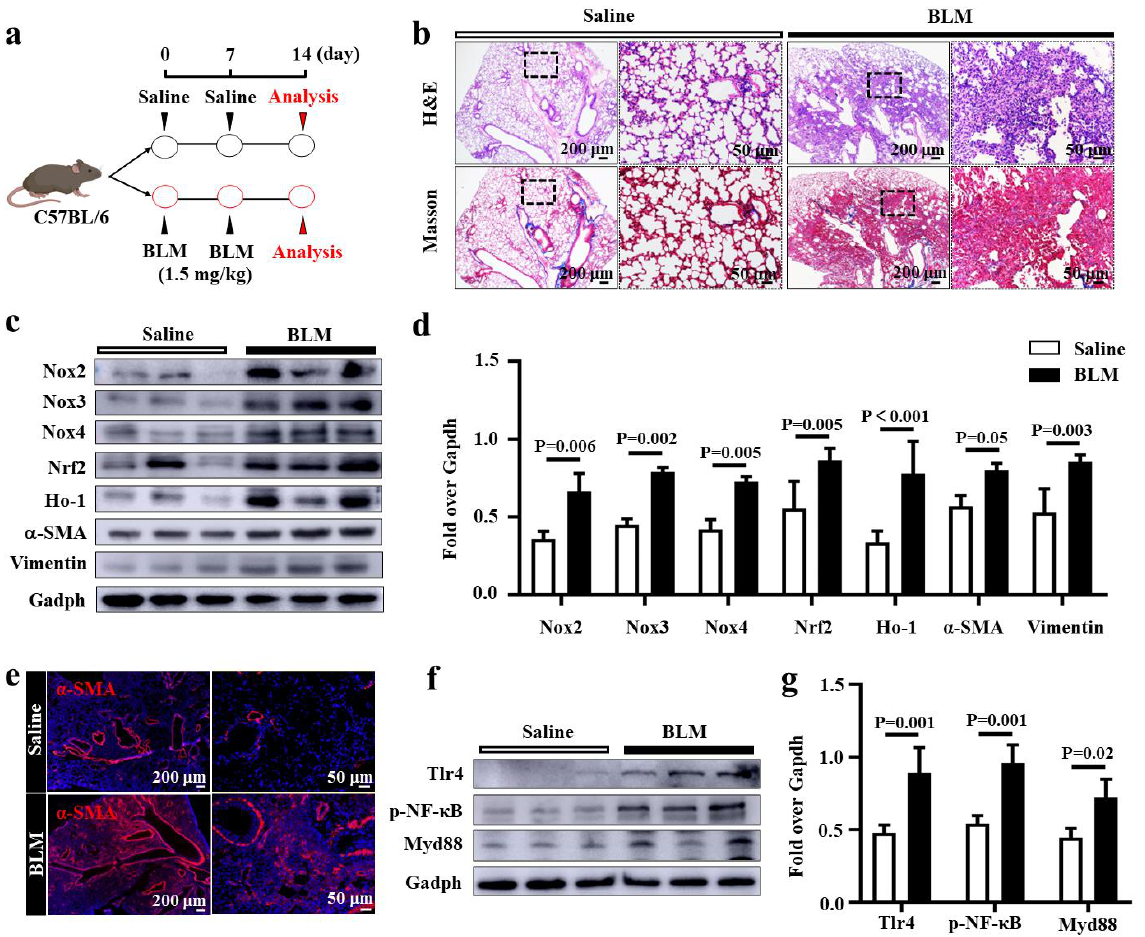
Figure 1. Elevated Nox-mediated oxidative stress and Tlr4/MyD88-mediated inflammation in lungs of mice with BLM-induced pulmonary fibrosis (PF). ( a ) Schematic diagram for the creation of the BLM-induced PF mouse model. C57BL/6 mice that were 6 – 8 weeks old were injured by intratracheal instillation of 1.5 mg/kg BLM at day 0 (d0) and d7, and the lung tissues were harvested at d14 post-injury for evaluation (N = 8). ( b ) Representative histochemical images of H&E and Masson staining demonstrated alveolar structural damage (H&E staining) with ECM deposition (Masson staining). ( c ) Representative immunoblotting blots demonstrated an increased expression of proteins of Nox family numbers (Nox2, Nox3, and Nox4), oxidization stress markers (Nrf2 and Ho-1), and EMT markers ( α -SMA and Vimentin) in the lungs of BLM-induced PF mice compared with the saline group. ( d ) Semi-quantitation of relative levels of proteins of interest as determined by the relative density over Gapdh in ( c ). ( e ) IF staining validated the increased abundance of α -SMA in the lungs of mice at d14 post-BLM challenge compared with saline controls. ( f ) Representative blots of immunoblotting assay demonstrated the enhanced activation of Tlr4/MyD88 signaling in the lung of BLM-induced PF mice model compared with the saline group. ( g ) Semi-quantitation of the relative levels of proteins of interest Tlr4, MyD88, and p-NF- κ B as evaluated by the relative density over Gapdh in ( f ). Data in ( d , g ) represent mean ± SD from the indicated number of mice (N = 3), as analyzed by GraphPad prism one-way ANOVA Tukey’s multiple comparisons